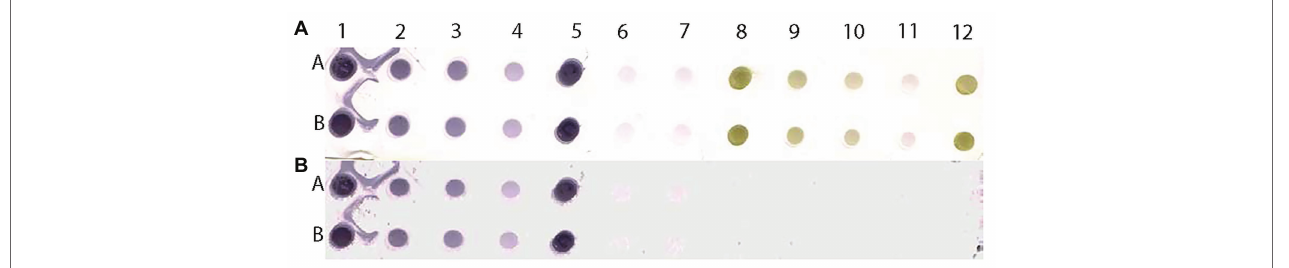
FIGURE 9 | Scanned image of a DE output of positive and negative controls of MilBVV (A) and reconstituted image (B) made by pixels with predicted probabilities above the 0.135 cutoff based on the LBVaV-trained model. Lanes A and B show duplicates of undiluted (1 and 5), and 1:5 (2) 1:10 (3), and 1:50 (4) dilutions of the positive control of MilBVV. Dots 6 and 7 are buffer only controls. Dots 8 to 12 contain the negative control of MilBVV undiluted (8, 12), and at 1:5 (9), 1:10 (10), and 1:50 (11) dilutions. The translation of unique antigens, of MilBVV here, to the universal basic color language allows for its detection by the algorithm (model) we built, even though it was trained on the basis of a different virus,